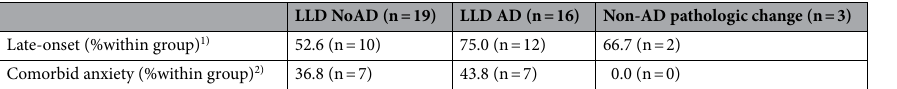
Table 2. Prevalence of Late-onset depression and comorbid anxiety in the LLD groups. Late-onset was defined when LLD occurred after the age of 60. Anxiety was defined in accordance to ICD10 (F41). Chi square for 1) 1.9 ( p = 0.40), for 2) 2.1 ( p =